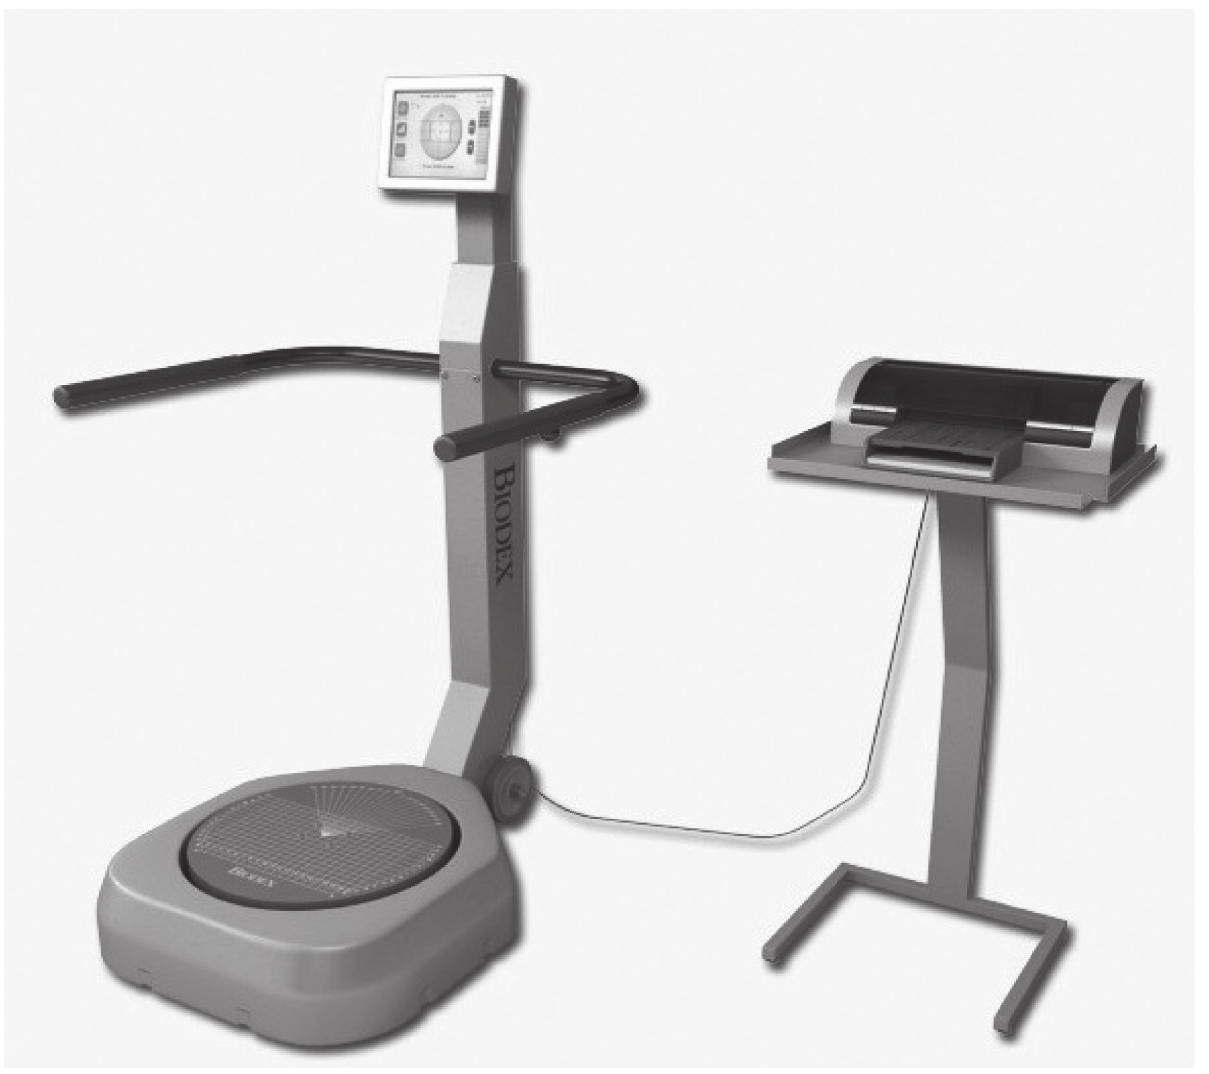
Figura 1 – Biodex Balance System Fonte: Balance System SD 1